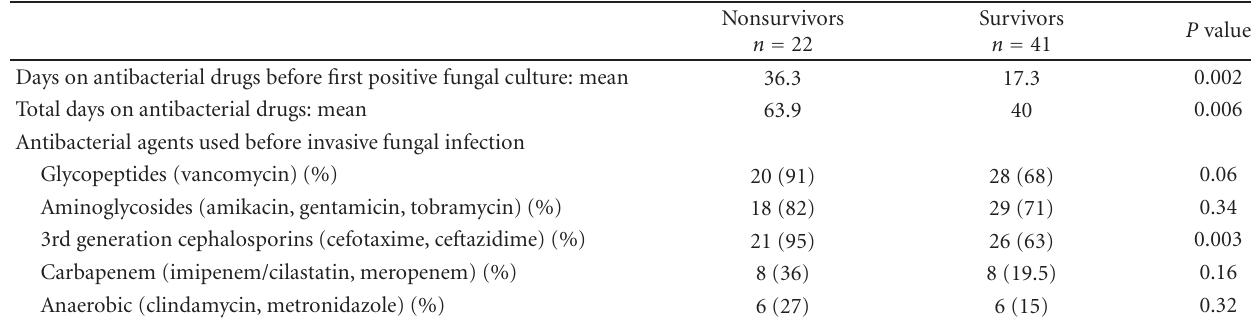
Table 2: Antibacterial use: comparison between mortality and survivor groups.